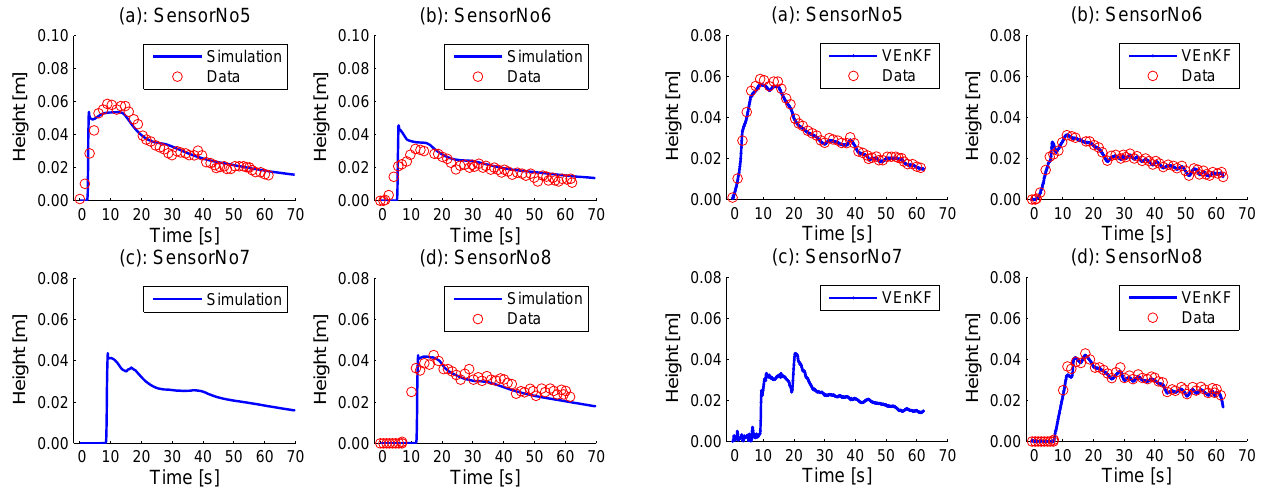
Fig. 10. Comparison of simulated water depth and measured depth of the dam break experiment for the last four sensors at the down- stream end. Sensor No. 7 did not have measurements.